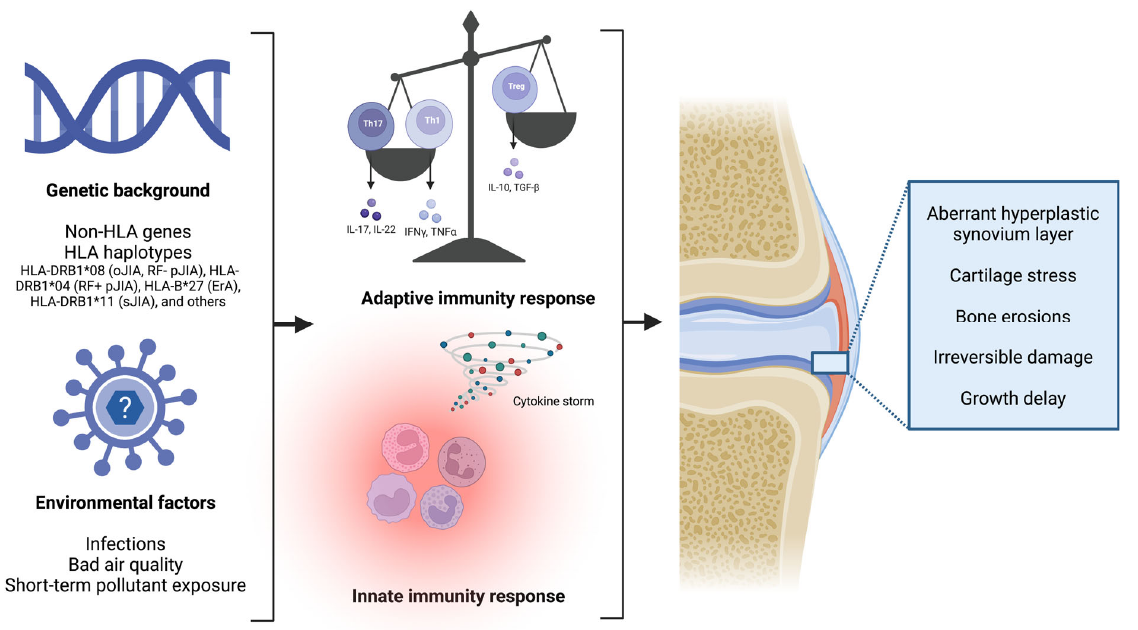
Figure 1. In children with a strong susceptible genetic background, a dysregulation of both the innate and adaptive immunity occurs, leading to cartilage stress and joint damage, up to permanent bone erosion damage (created with “BioRender.com”, accessed on 7 January 2023).